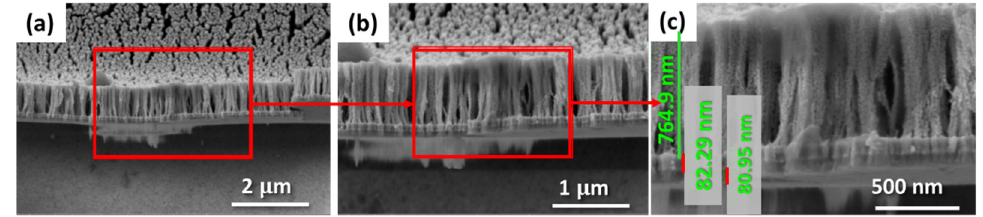
Figure 12. ( a ) Cross-section SEM micrograph of porous gold substrates at different magnification ( b , c ).